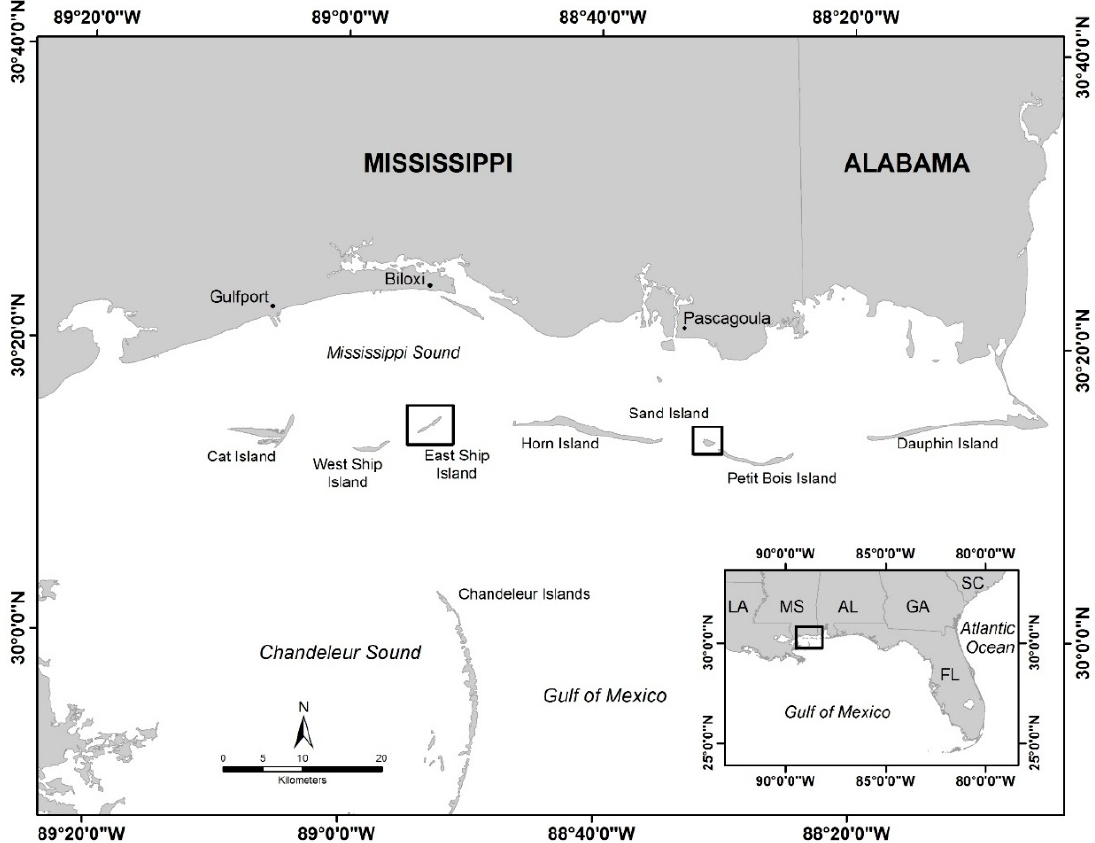
Figure 1. The MS barrier island chain, USA, showing the East Ship and Sand Island study sites.